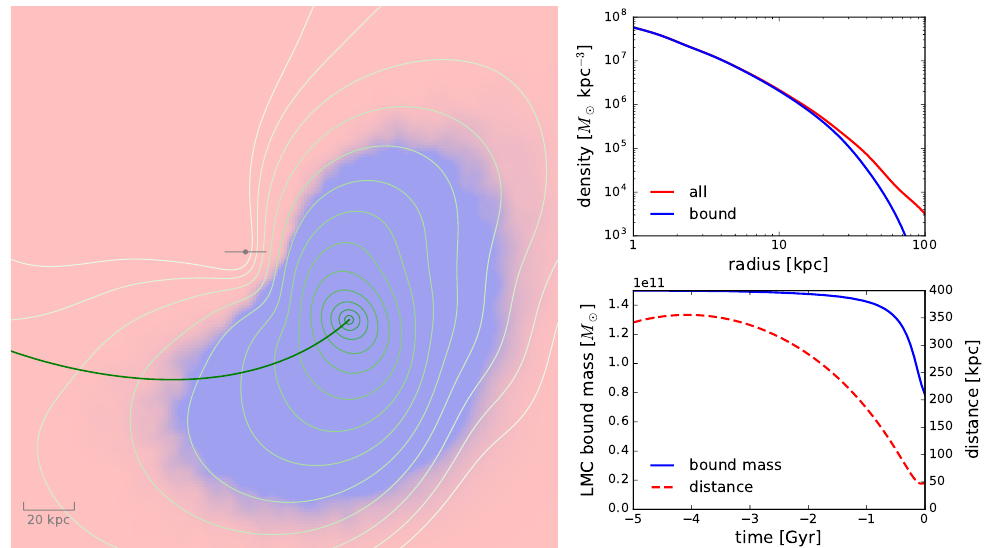
Figure 7. Illustration of tidal deformation and mass loss of the LMC. Left panel shows the projected density contours of the LMC particles at the present time in the same orientation as in Figure 5, top panel. The inner blue-shaded region contains particles still bound to the LMC (having negative energy in the associated reference frame), while particles in the outer red-shaded region are unbound. The Milky Way disc is shown by a grey line with the dot marking its centre, and the past orbit of the LMC is shown by a green curve. The top right panel shows the spherically averaged density profile of all (red) and bound (blue) particles, with the bound fraction dropping precipitously beyond 30–40 kpc from the LMC centre. The bottom right panel shows the time evolution of bound mass (blue) and Galactocentric distance (red) of the